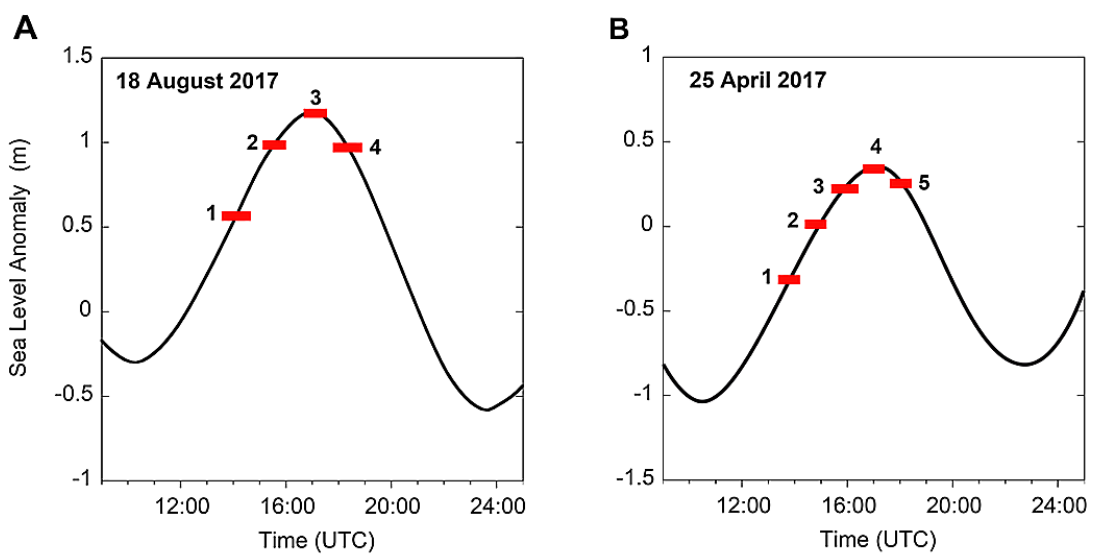
Figure 10. Time of the ADCP cross-bay sections performed in winter ( A , August 2017), and autumn ( B , April 2018). Numbers are the successive sampled sections in the different tidal moments. Tidal parameters were obtained from http://www.hidro.gov.ar/oceanografia/Tmareas/RE_Mareas.asp. The average currents for the high sea period during the stratified and non-stratified seasons are